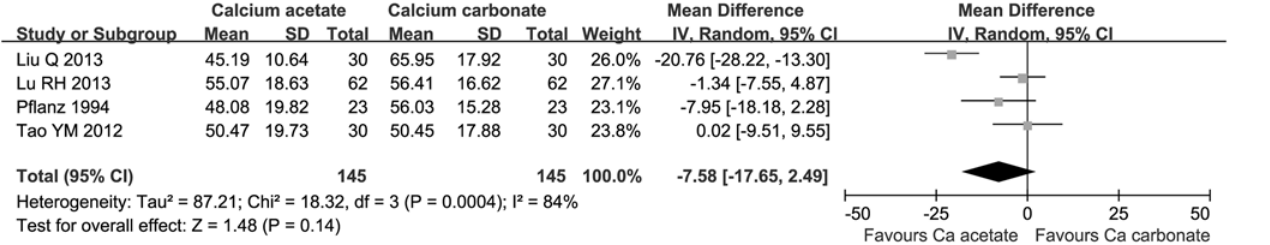
Fig 4. Serum calcium by phosphorus (Ca x P) products after 8 weeks administration of calcium-based phosphate binders.